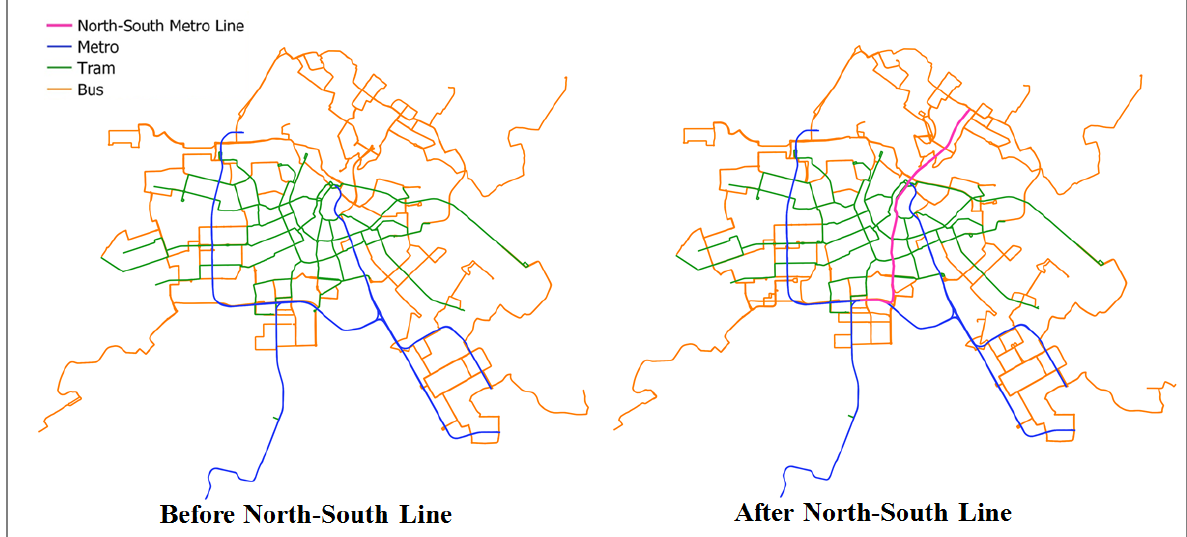
Figure 4. metro line (data provided by